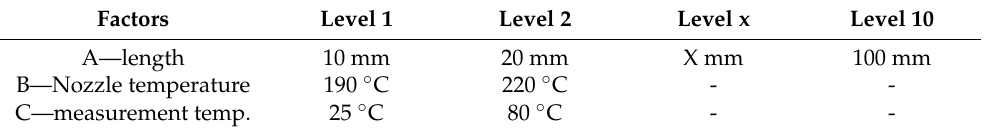
Table 3. Factors and levels for design of experiment for resistance measurement. Factors Level 1 Level 2 Level x Level 10 A—length 10 mm 20 mm X mm 100 mm B—Nozzle temperature 190 ◦ C 220 ◦ C - - 25 ◦ C 80 ◦ C - -